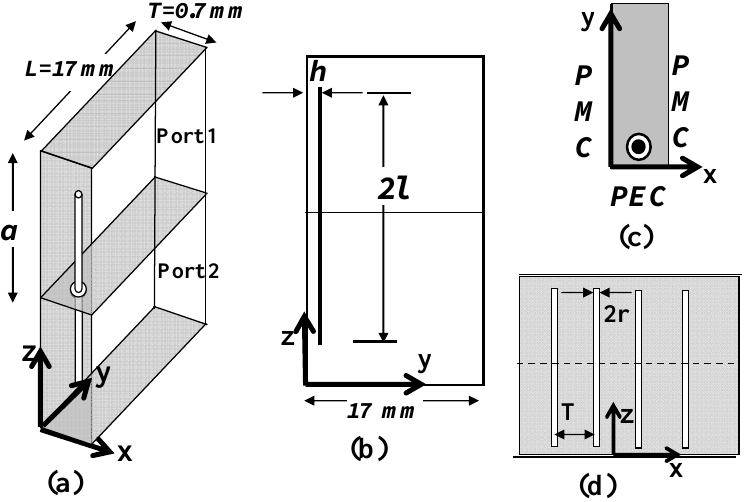
Figure 2. ( a ) Unit cell of the parallel-plate waveguide configuration that supports energy tunneling. The shaded walls are the perfectly electric conductors (PECs) and the un-shaded walls are perfectly magnetic conductors (PMCs); ( b ) side view and ( c ) top view showing the boundary conditions; ( d ) the infinitely extended x-y plane. Waveguide dimensions are given by a = 3.56 mm, r = 0.04 mm, R = 0.12 mm and h = 0.178 mm. (The picture is not drawn to the